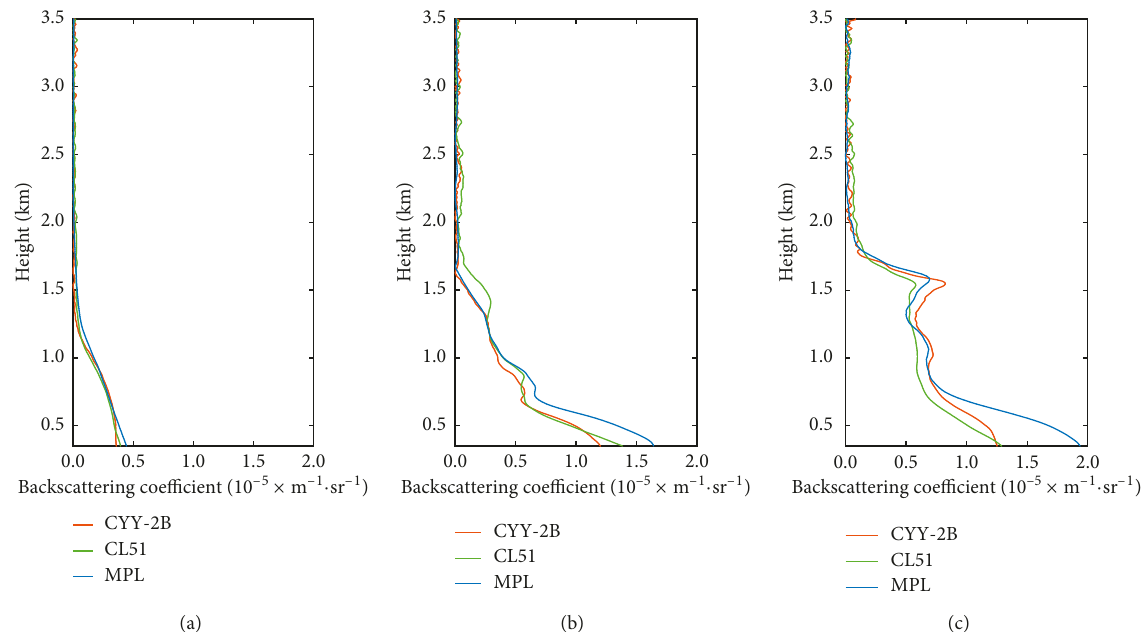
Figure 2: Differences in extinction coefficient profiles derived from two ceilometers and the MPL. (a) 4-Dec-2011 10:59:52. (b) 15-Feb-2012 10:59:48. (c) 27-Feb-2012